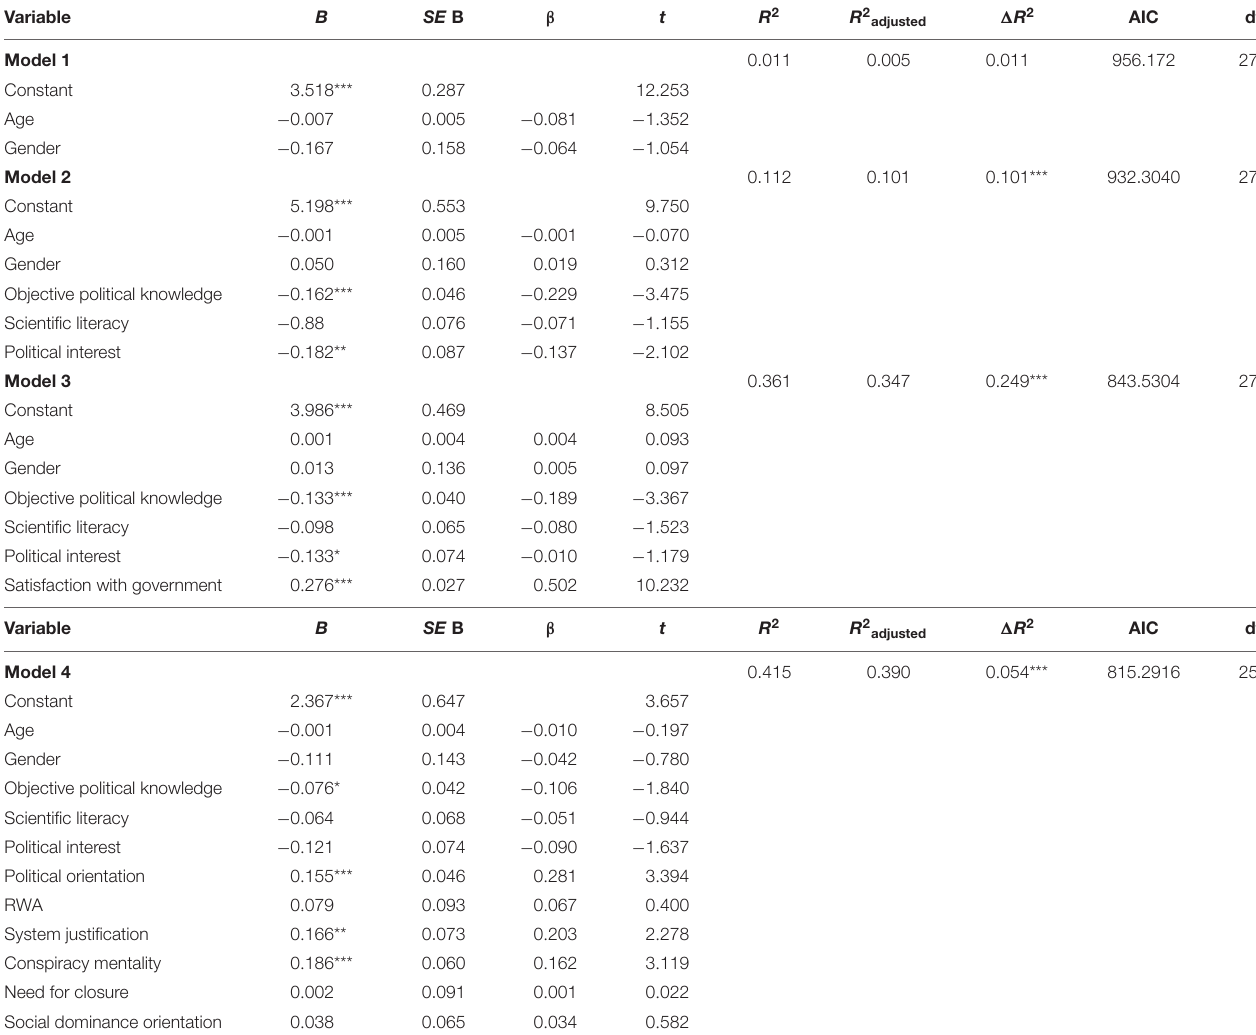
TABLE 7 | Hierarchical regression results for belief pro-government fake